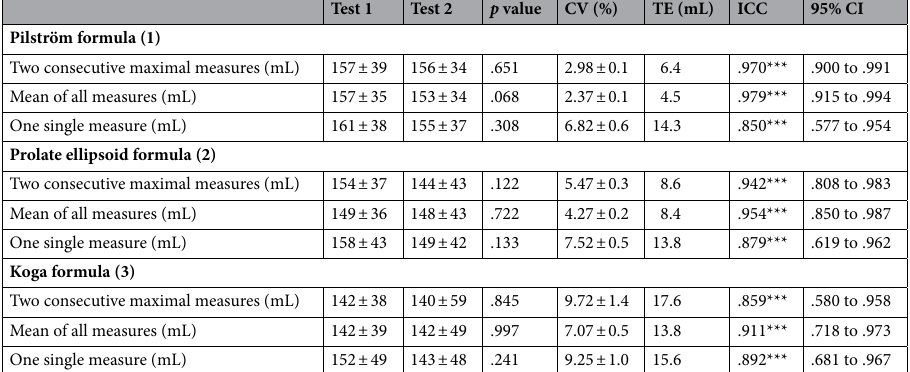
Table 1. Comparisons of three different methods of establishing baseline splenic volume (Mean ± SD) between repeated tests using different formulas with corresponding reliability measures. *** p <